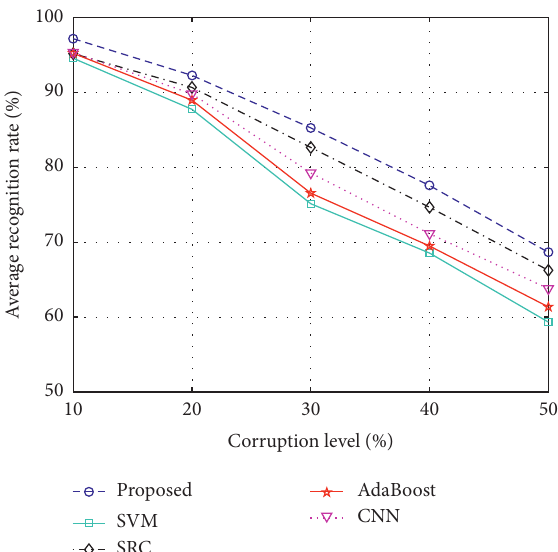
Figure 7: Performance of methods with regard to random noise